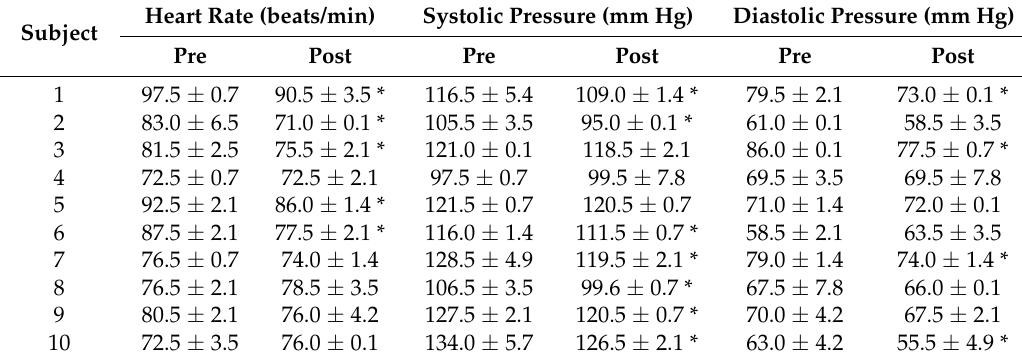
Table 2. Heart rate, systolic pressure, and diastolic pressure on the pre- and post-inhalation of volatile organic chemicals (VOCs) in Chrysanthemum indicum Linn é